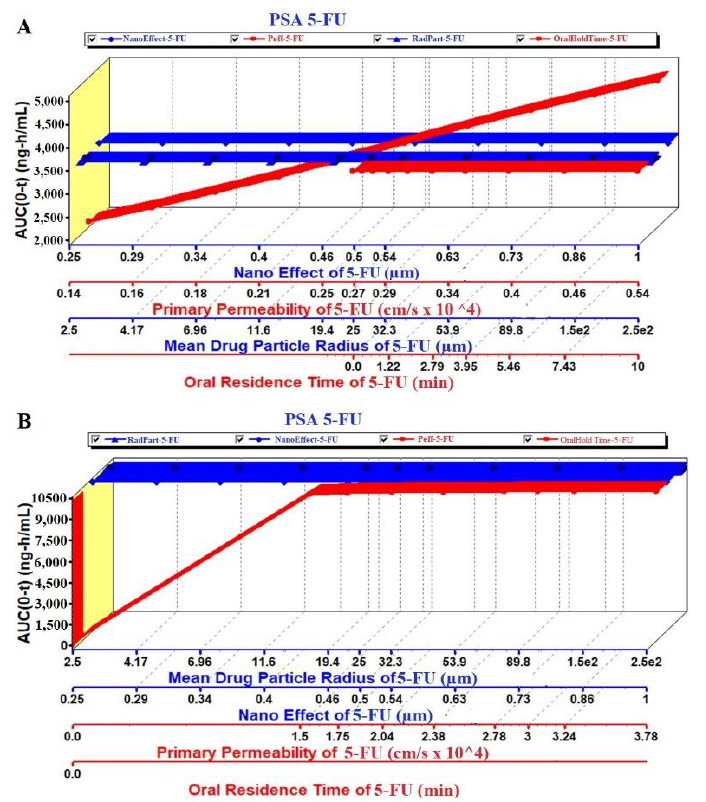
Figure 10. PSA of the pure 5-FU and 5-FU loaded NPs: ( A ) Effect on AUC 0-t of 5-FU and ( B ) Effect on AUC 0-t of 5-FU loaded NPs.